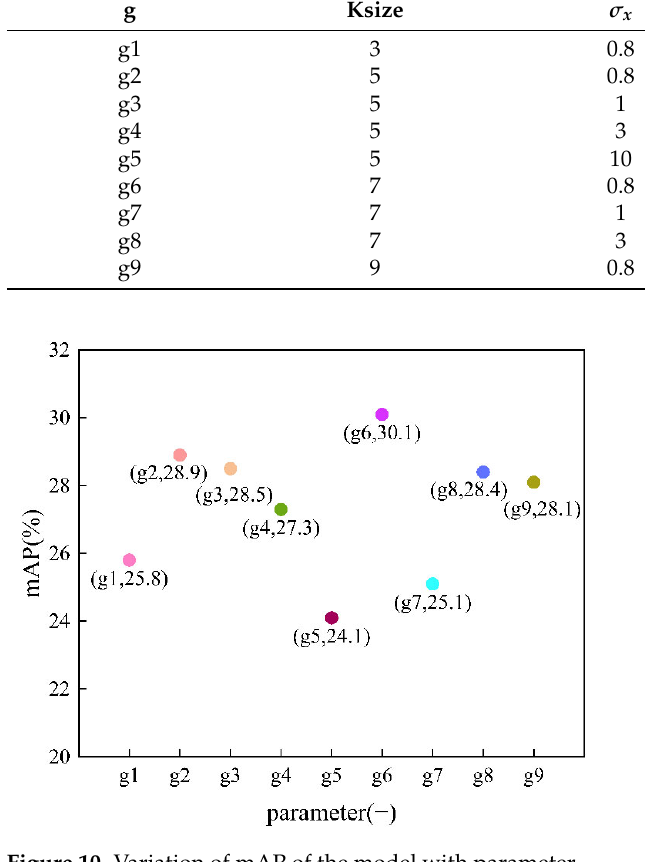
Figure 10. Variation of mAP of the model with parameter.